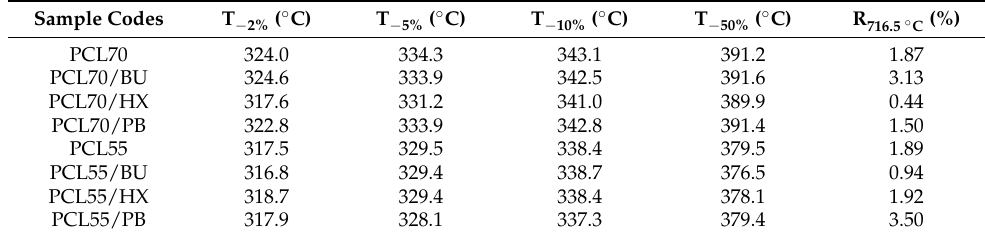
Figure 5. TGA and DTG curves of PCL/PLA blends. Table 4. Thermal degradation parameters of PCL/PLA blends. Table 4. Thermal degradation parameters of PCL/PLA